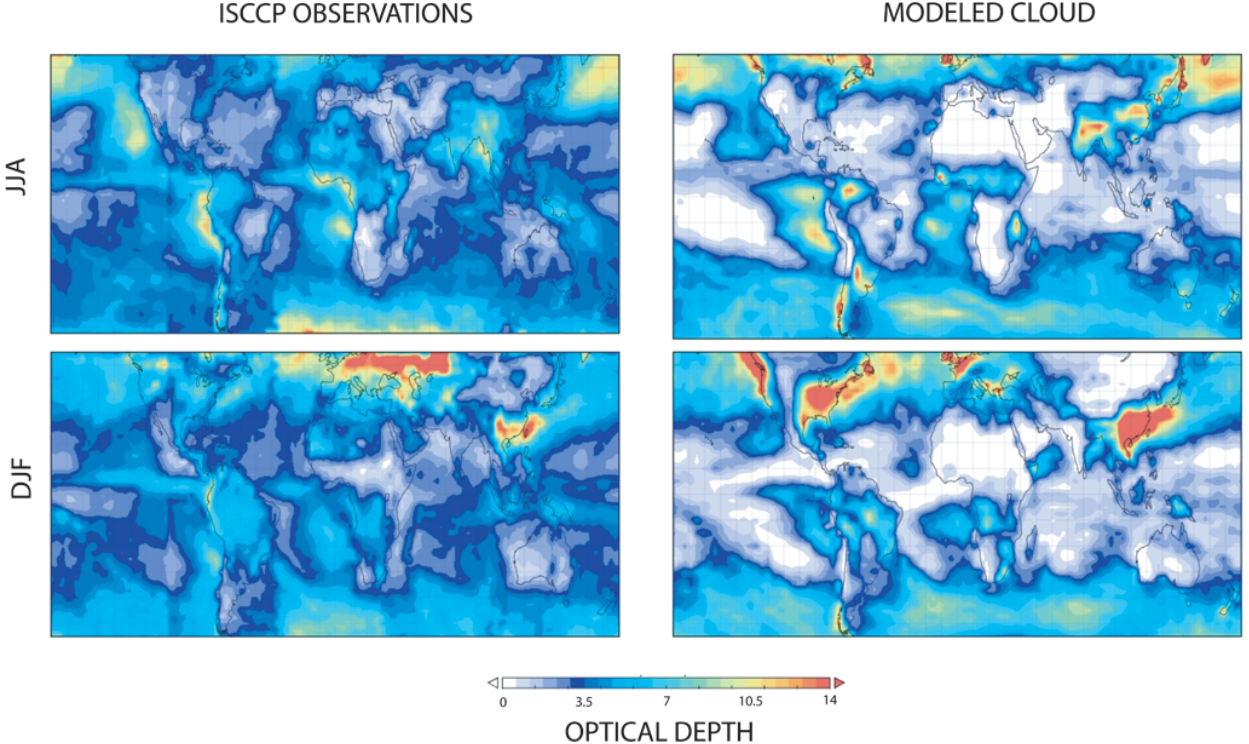
Fig. 2. Average cloud optical depth from ISCCP satellite data (left) and the UM (right). The top row contains a comparison for the Northern Hemisphere summer season and the bottom row for the winter